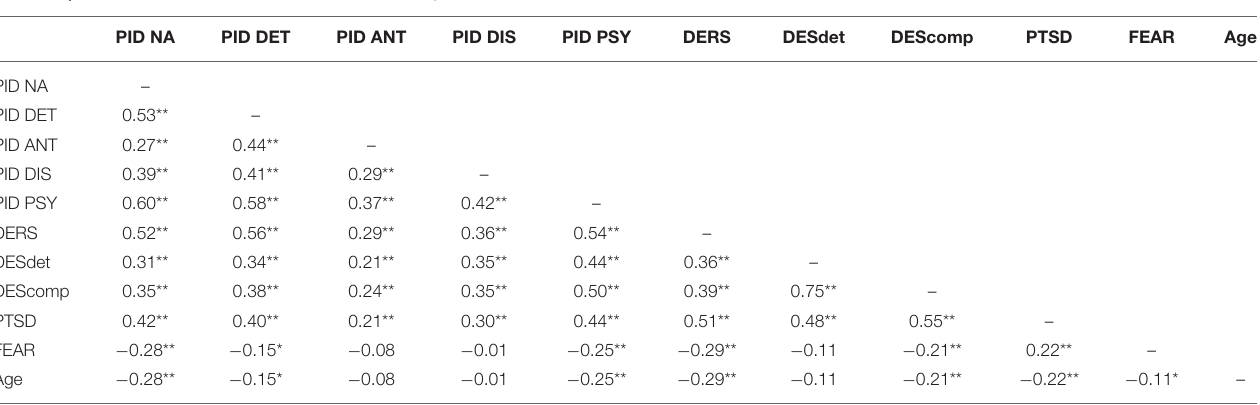
TABLE 1 | Correlations between main variables of the